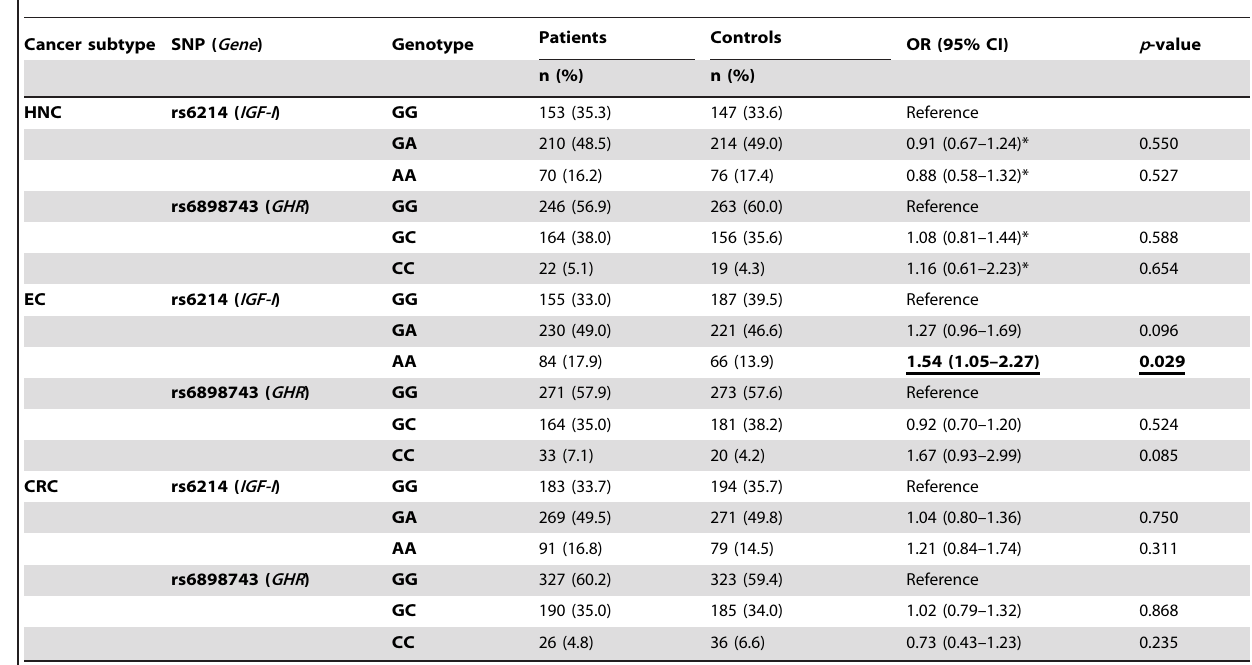
Table 4. Genotype distribution and ORs (95% CI) per cancer subtype, for the genotypes of SNPs rs6214 and rs6898743.